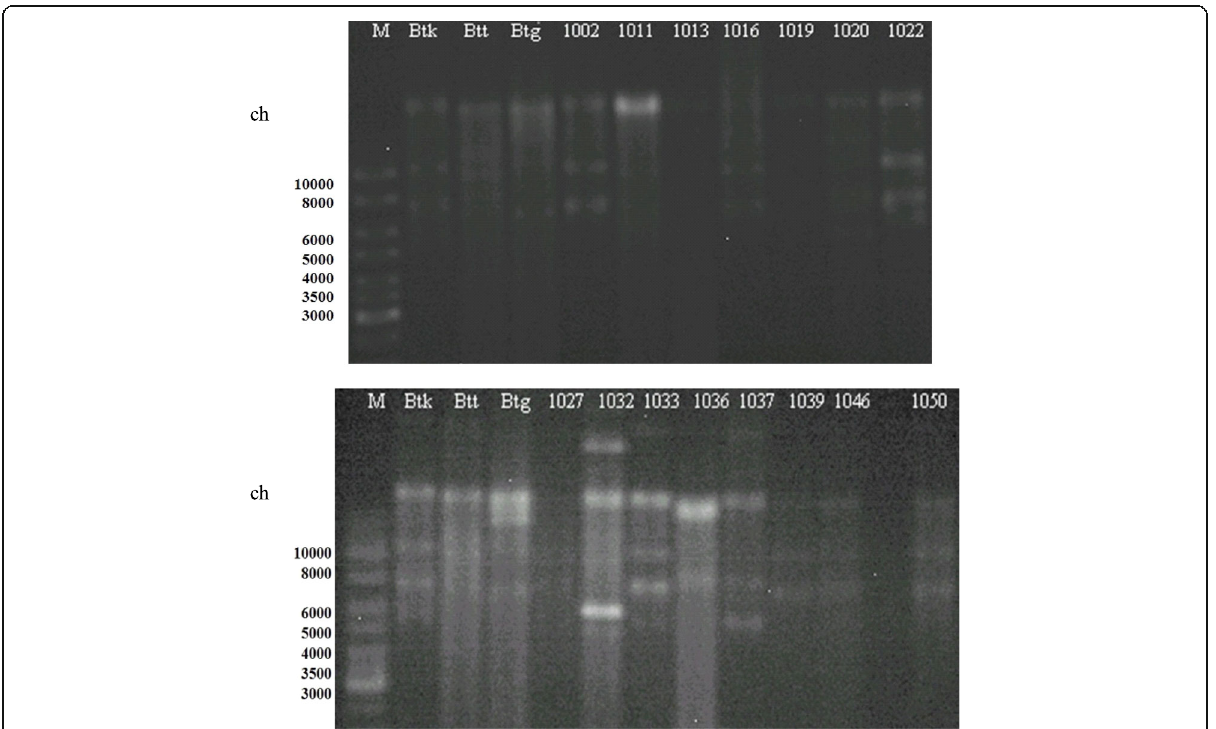
Fig. 2 Plasmid profile of Iranian Bacillus thuringiensis isolates; M , Marker (bp); reference strains: Ch , Chromosomal DNA band; Bt kurstaki ; Bt thuringiensis; and Bt